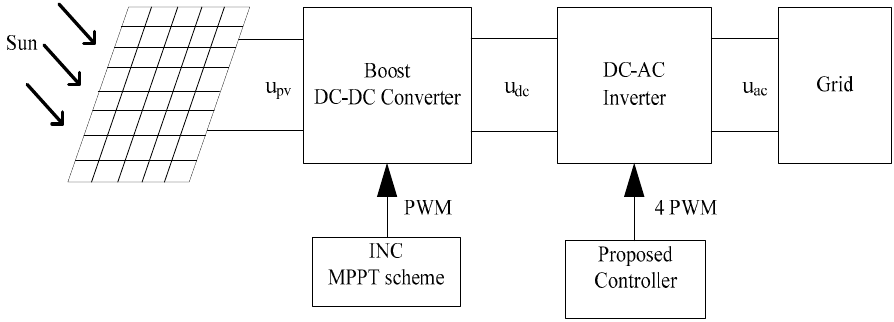
Figure 1. Single-phase grid-connected PV inverter model.